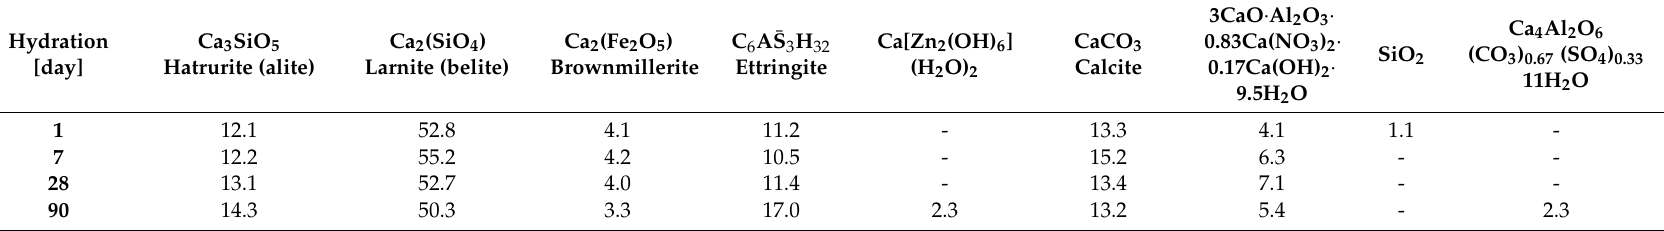
Table 4. Mineral composition of sample with Zn(NO 3 ) 2 · 6H 2 O.